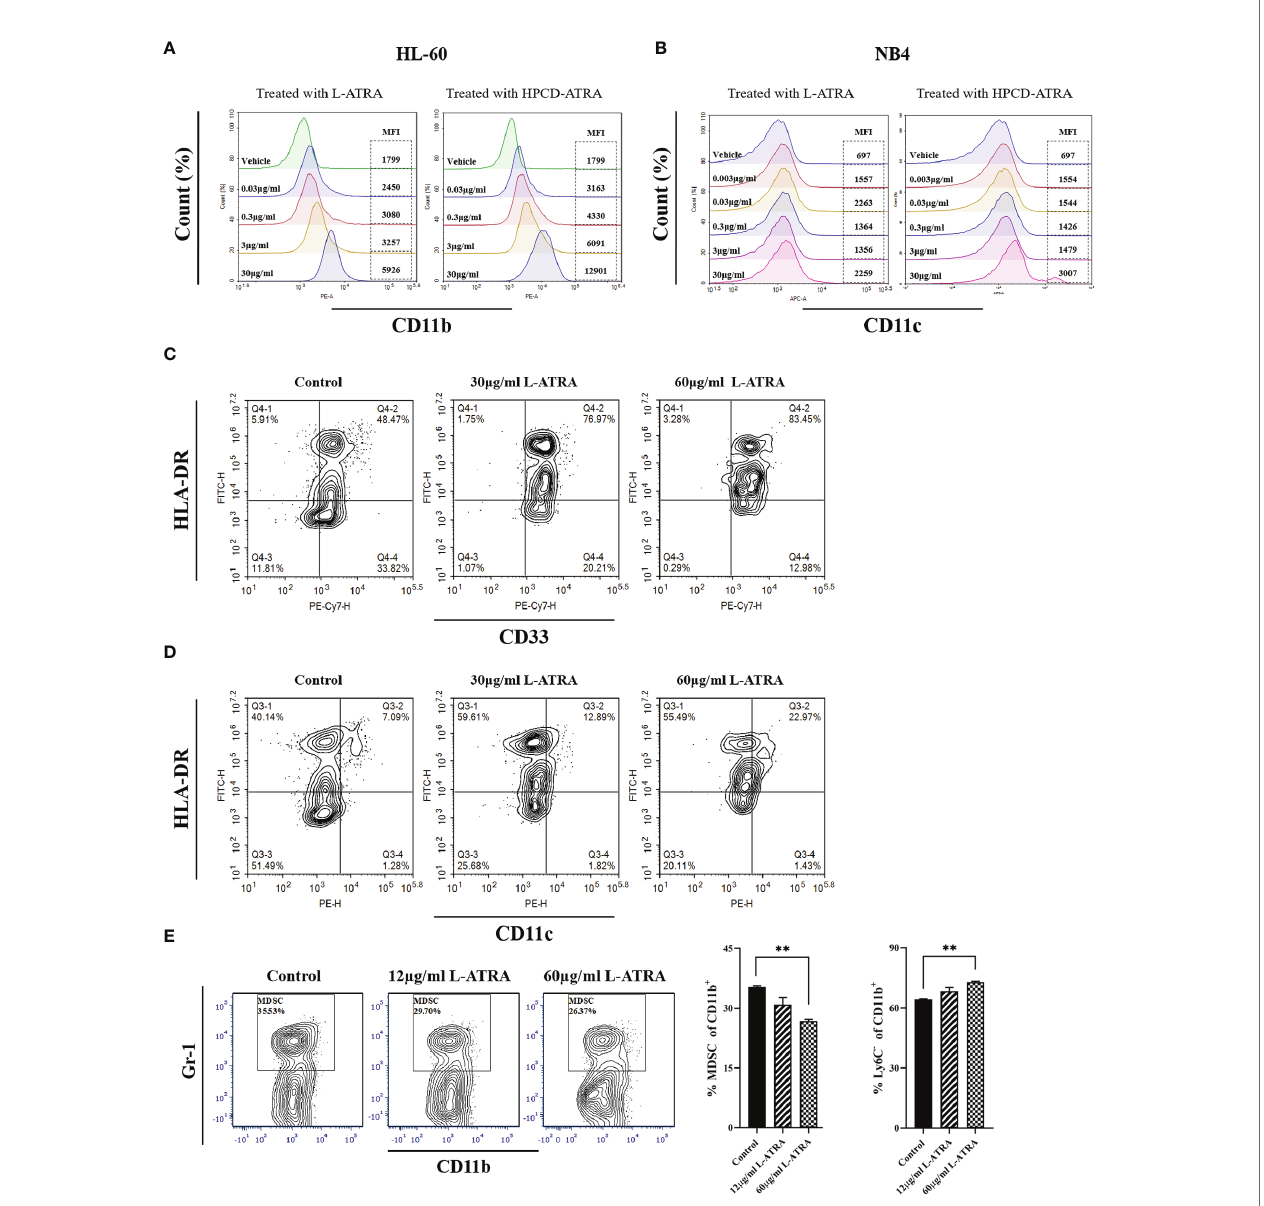
FIGURE 2 | The in vitro L-ATRA dose effects on MDSCs. (A, B) The dose effects of L-ATRA on human leukemia cell line HL-60 cells and NB4 cells; (C, D) L-ATRA treatment of PBMCs isolated from cancer patient blood samples. (E) L-ATRA treatment of isolated CT-26 mouse tumor in fi ltrating myeloid cells. The percent of MDSCs in CD11b + myeloid cells and percent of Ly6C - cells in CD11b + myeloid cells were also plotted as bar graphs on the right (**p < 0.01, one- way ANOVA